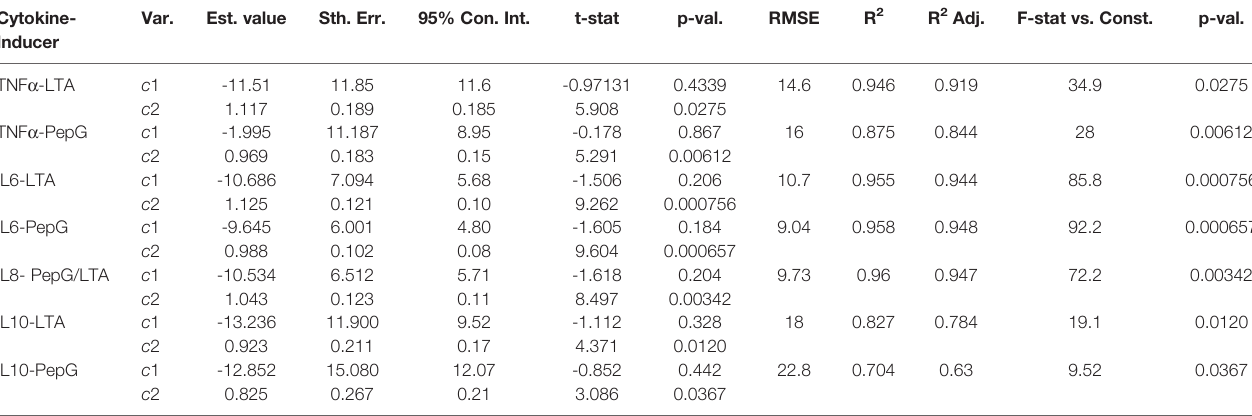
TABLE 3 | LLS regressions of simulated results for each cytokine vs. experimental data of immune response to LTA and PepG. Cytokine- Inducer